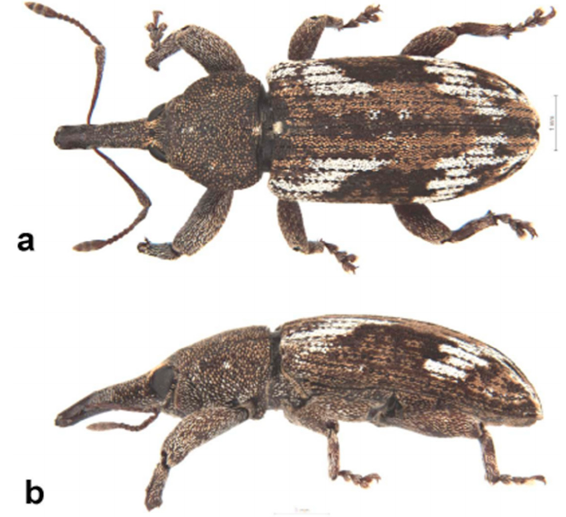
Figure 15. Notopissodes pictus : ( a ) habitus of male, dorsal aspect; ( b ) habitus of male, lateral aspect.